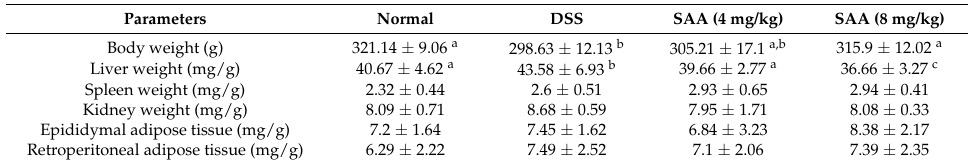
Table 1. Body weight, organ index, and fad pad weights of the rats 1